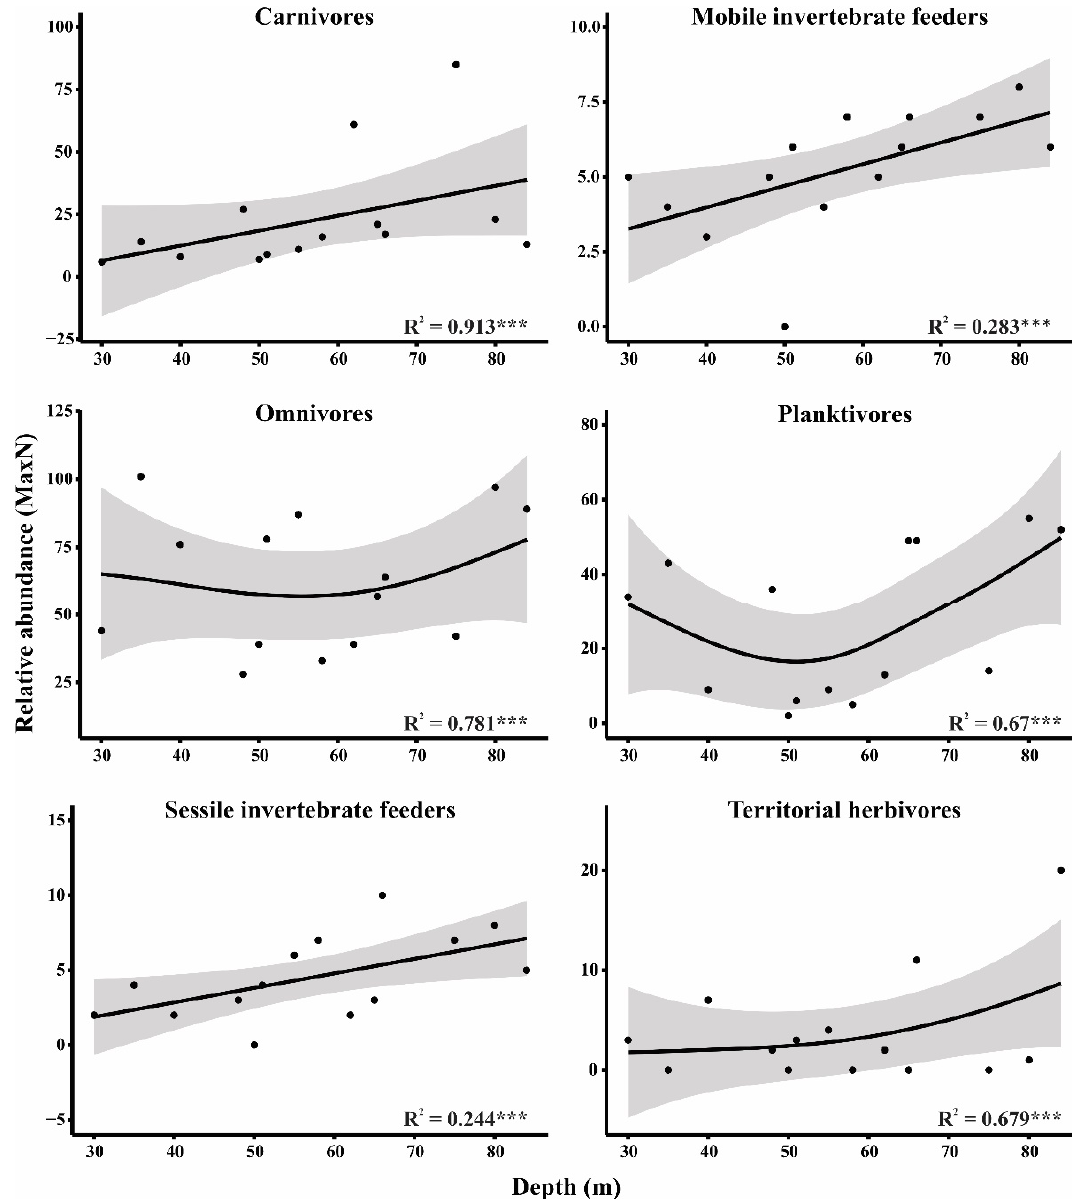
Figure 5. Relationship between relative abundance (MaxN) of the trophic groups and depth according to the generalized additive models. Each dot represents a BRUVS deployment. 95% confidence limits are shown in gray. *** p < 0.001.